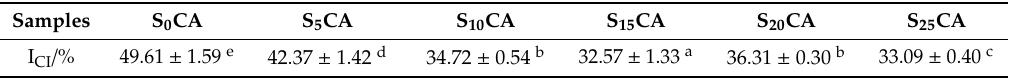
Table 2. Crystallinity (I CI ) value of aerogel with di ff erent starch